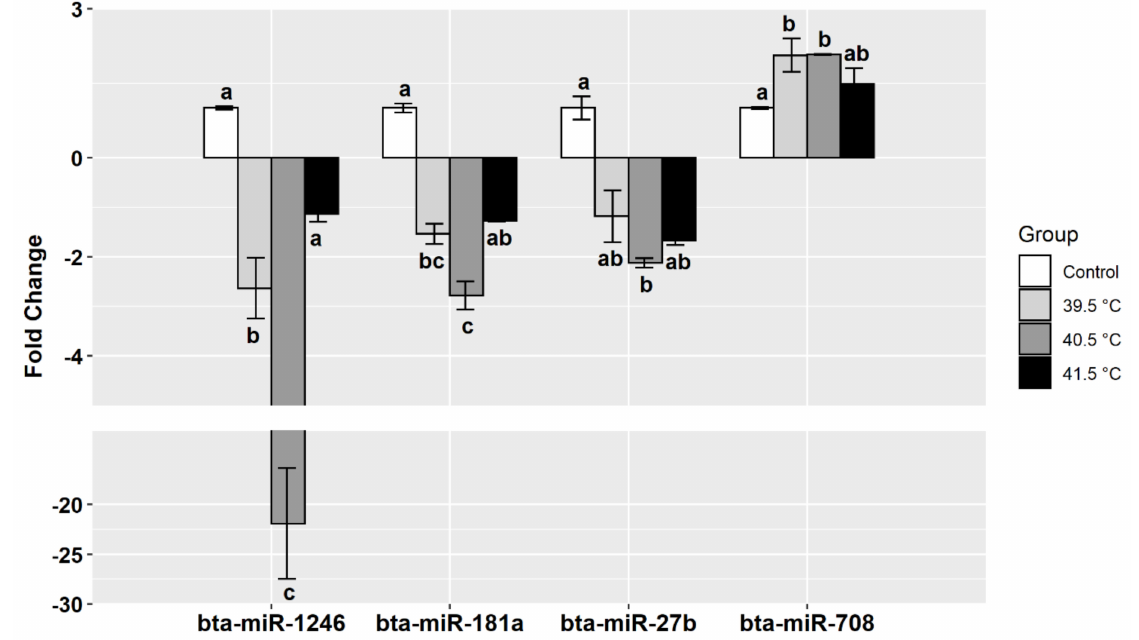
Figure 4. Expression analysis of selected miRNAs in buffalo granulosa cells post-heat treatment (39.5 ◦ C, 40.5 ◦ C, or 41.5 ◦ C for the last 24 h of culture) compared to the control group (37 ◦ C). Bars with different letters indicate significant differences between groups ( p < 0.05) and data from three biological